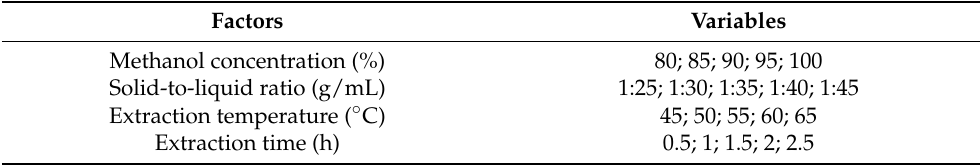
Table 3. The factors and variables of single-factor